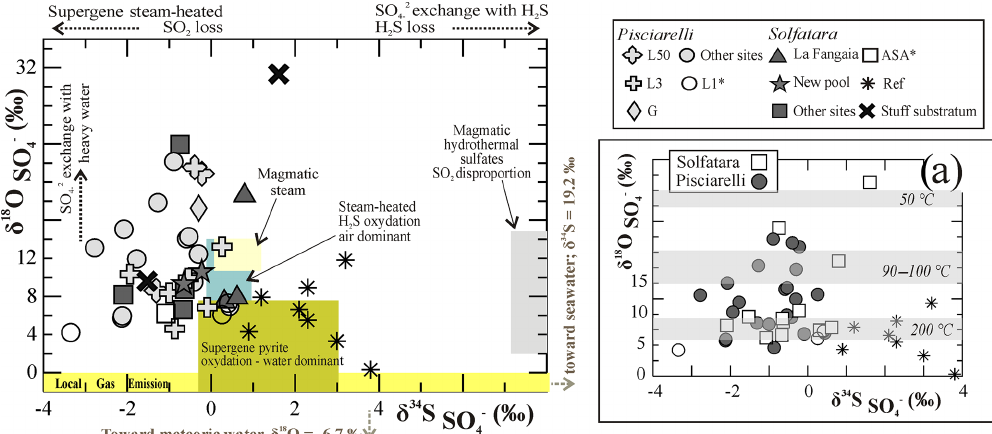
Figure 7. Covariation of δ 34 S vs. δ 18 O values in sulfates, symbolized to distinguish the specific materials on the basis of sampling sites. Modern marine sulfate, meteoric water (in the diagram), the δ 18 O values of local gas emissions and literature data are based on Cortecci et al. (1978), Allard et al. (1991), Valentino et al. (1999), Chiodini et al. (2016), Caliro et al. (2007) and Piochi et al. (2015). δ 18 O values of local outgassing are − 2‰ to 0‰. Fields and processes based on Rye et al. (1992) and Rye (2005). Panel (a) highlights Solfatara and Pisciarelli samples; shaded areas define the δ 18 O values we recalculated based on Rye et al. (1992) at the indicated temperature. Fields and processes based on Rye et al. (1992) and Rye (2005); “Ref” indicates literature data.